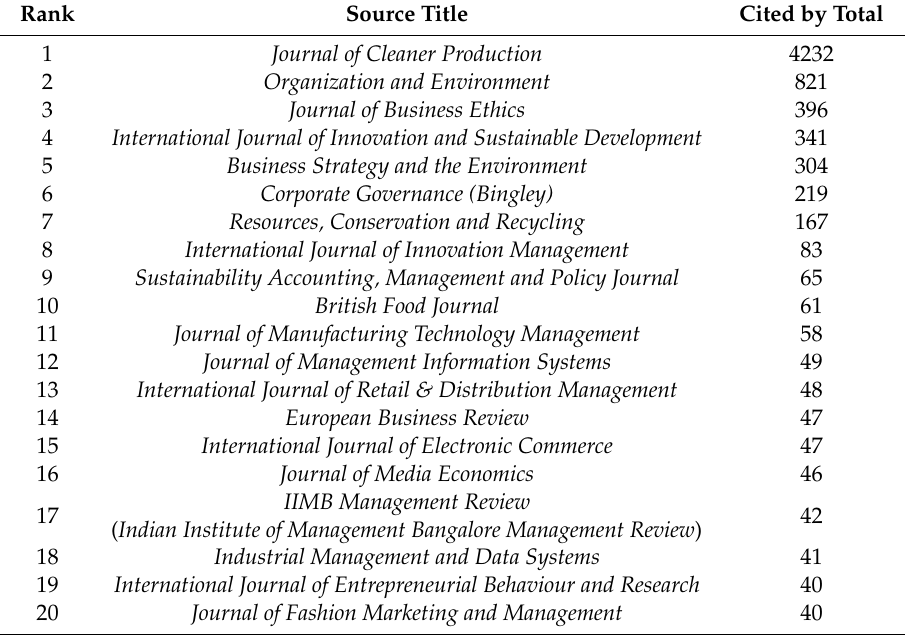
Table 5. Most cited journals in sustainable business models’